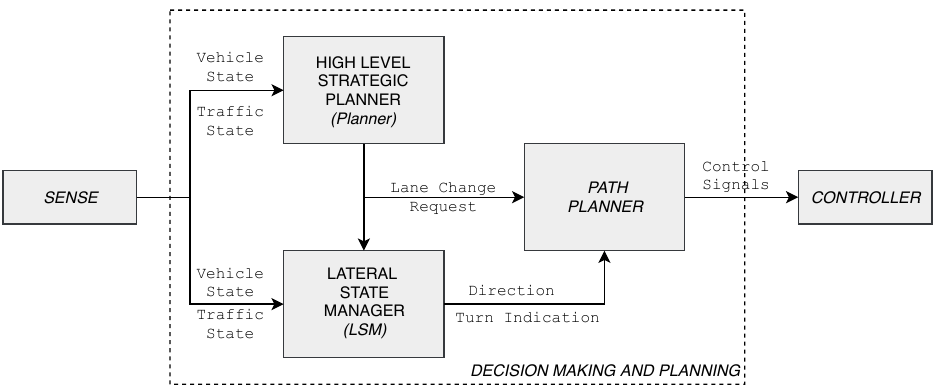
Figure 1. The lane change module system overview and interactions between the three components: Planner , LSM , and Path Planner